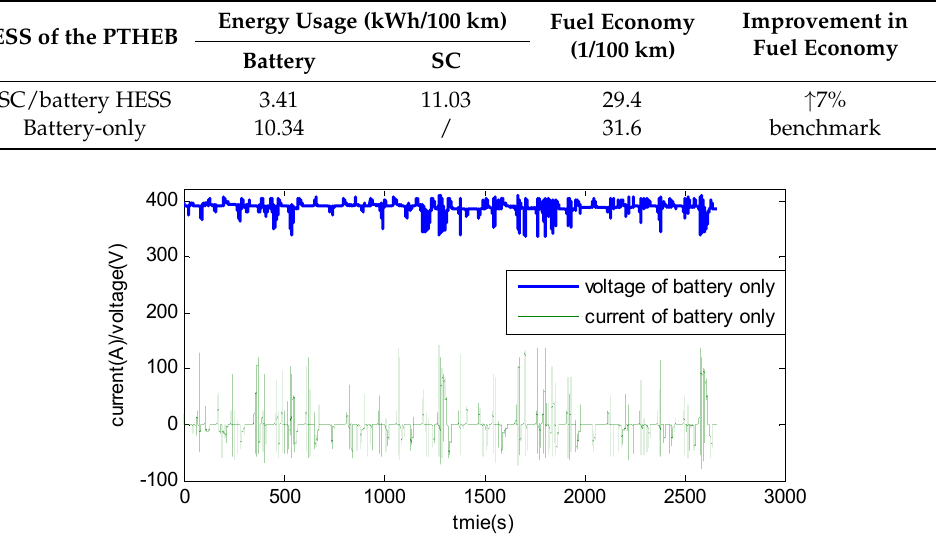
Figure 24. The battery current and voltage curves in battery-only PTHEB.